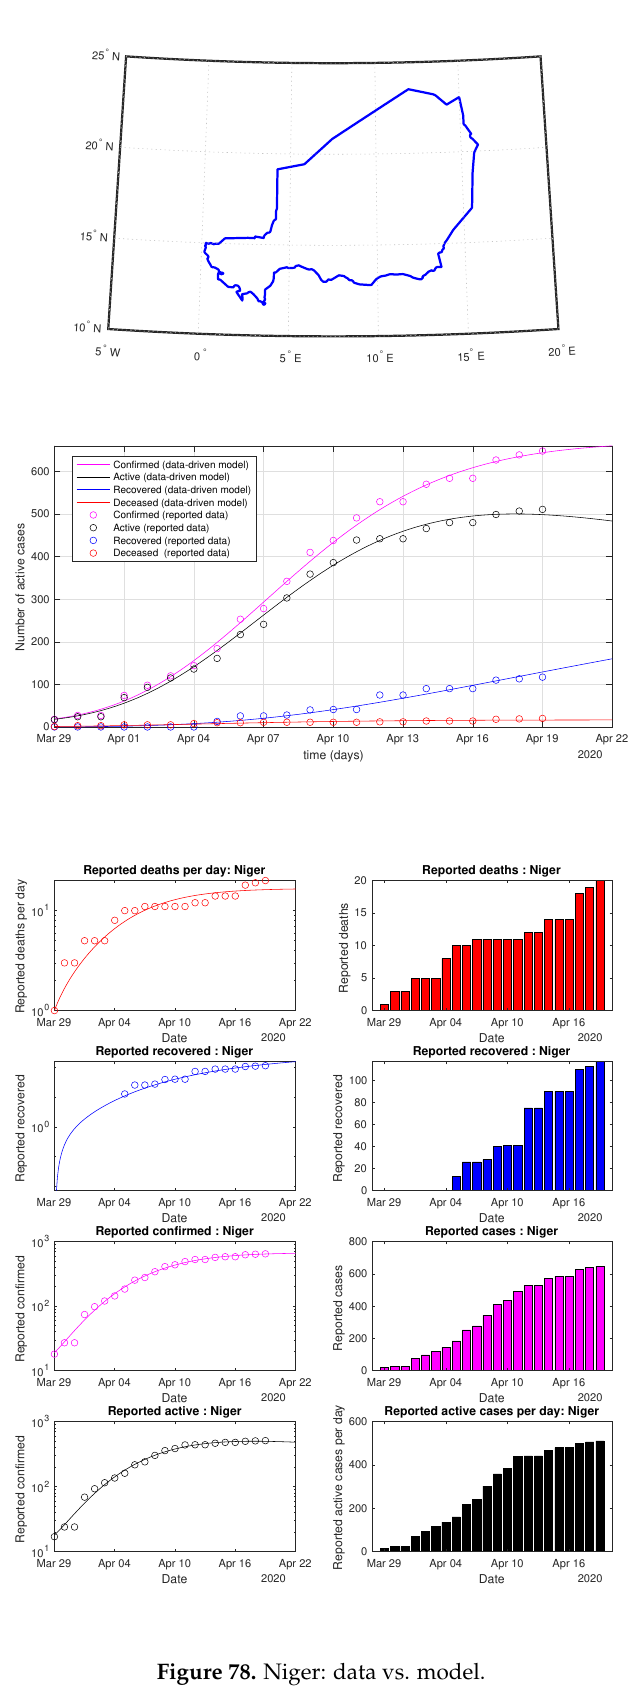
Figure 78. Niger: data vs.